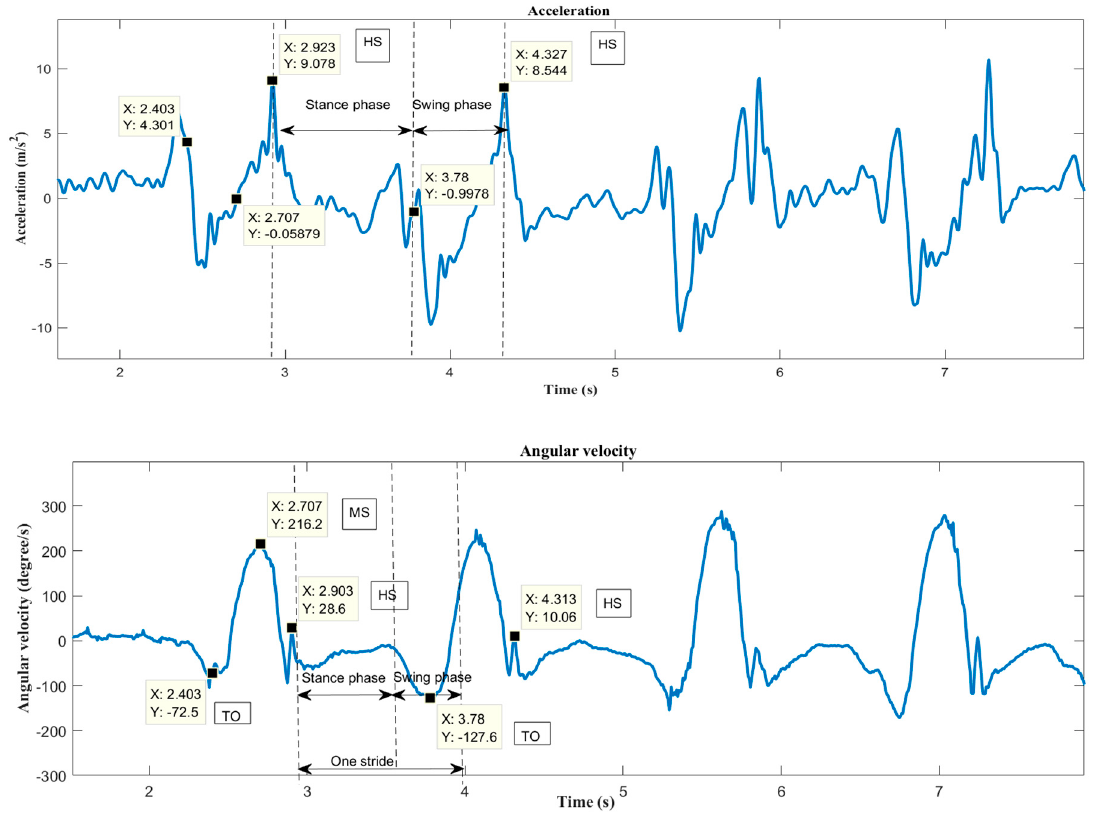
Figure 5. Acceleration and angular velocity curves showing HS, TO and MS of one stride.